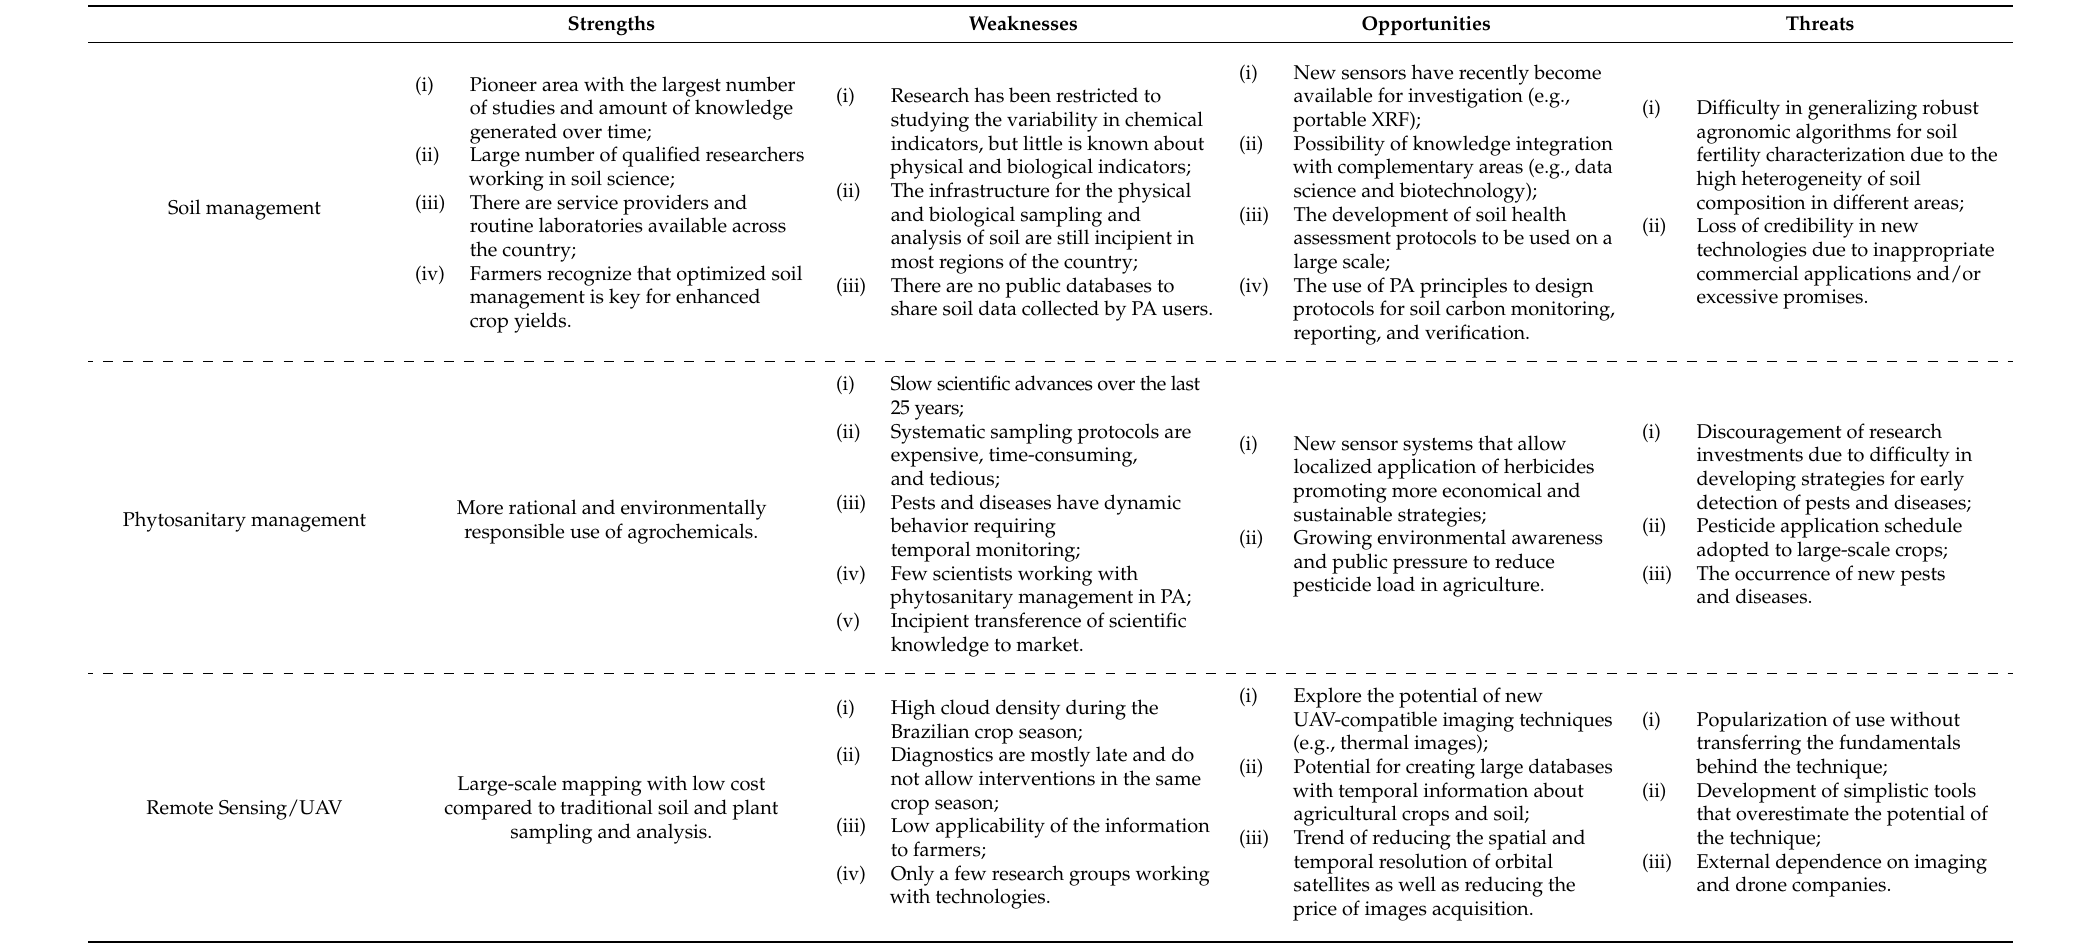
Table 1. Strengths, weaknesses, opportunities, and threats (SWOT analysis) of each PA research area in Brazil that summarize the main messages and implications learned from this